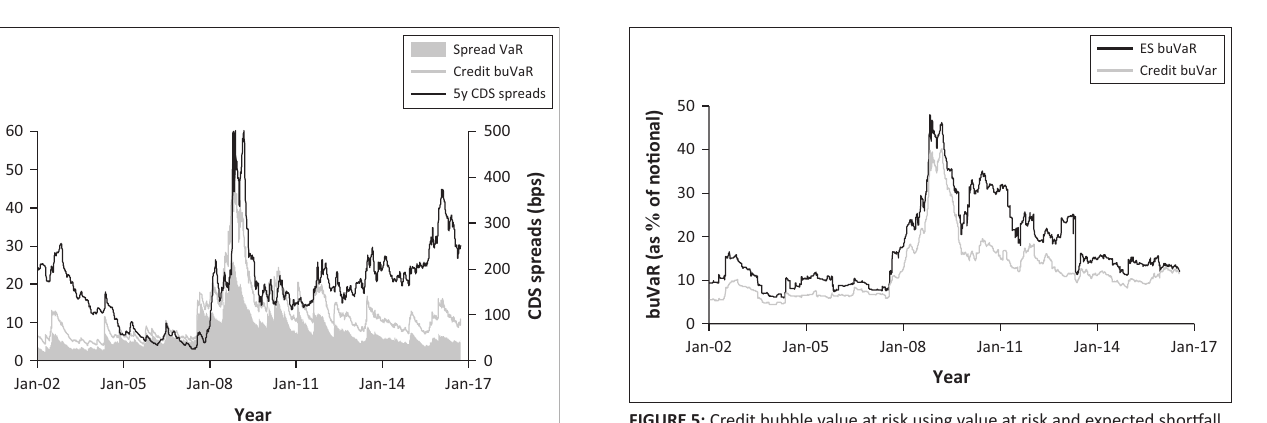
Figure 6 applies the buVaR model to 10-year South African government bond CDS spreads. The calibration of ω remains identical to that chosen for five-year South African government bond CDS spreads as this value produces similar capital retention levels (c.f. Figure 2).